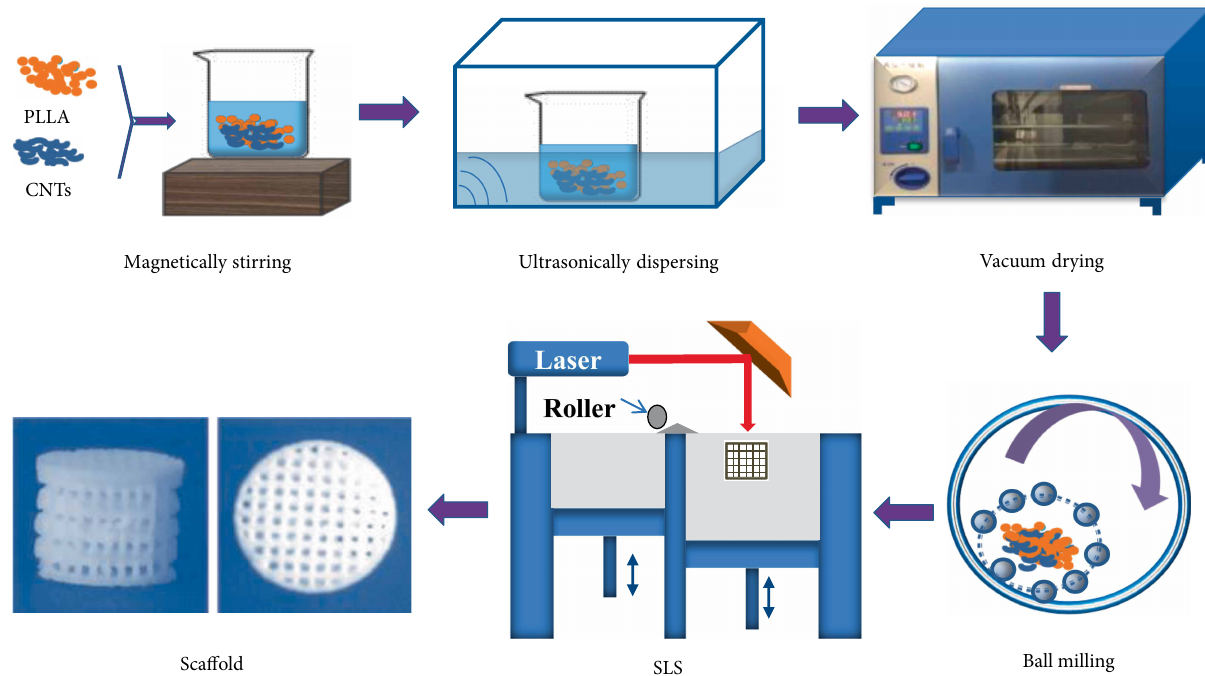
Figure 1: Schematic of the scaffold preparation